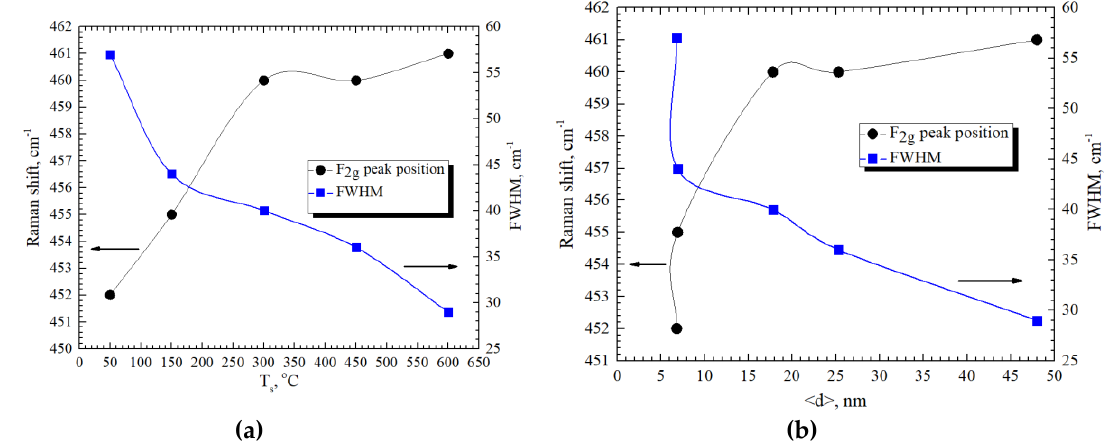
Figure 7. Change of the F 2g mode peak position and FWHM with respect to ( a ) substrate temperature and ( b ) crystallite size of SDC20 on SiO 2 substrates and using the deposition rate of 1.6 nm/s.